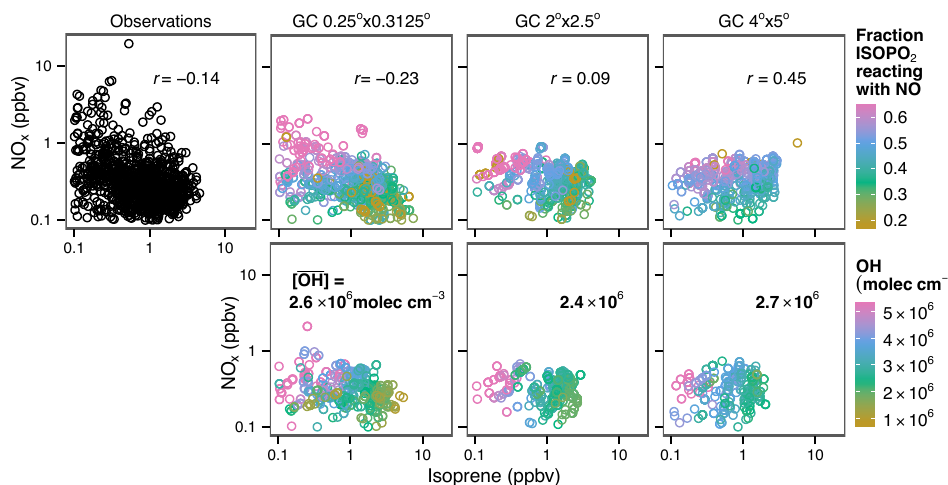
Figure 2. Relationship between NO x and isoprene concentrations in the mixed layer in SEAC 4 RS. Observations (60-s average) are compared to the GEOS-Chem (GC) simulations at different resolutions sampled along the flight tracks over the Southeast US domain of Fig. 1. Pearson’s correlation coefficients ( r ) are inset. The top model panels are colored by the fraction of the first-generation isoprene peroxy radical (ISOPO 2 ) reacting with NO; a fraction less than 0.5 indicates that low-NO x pathways dominate for isoprene oxidation. The bottom model panels are colored by the OH concentration, restricted to midday points (10:30–14:30 local time). Regional mean values computed along the flight tracks (primarily daytime) are given inset.